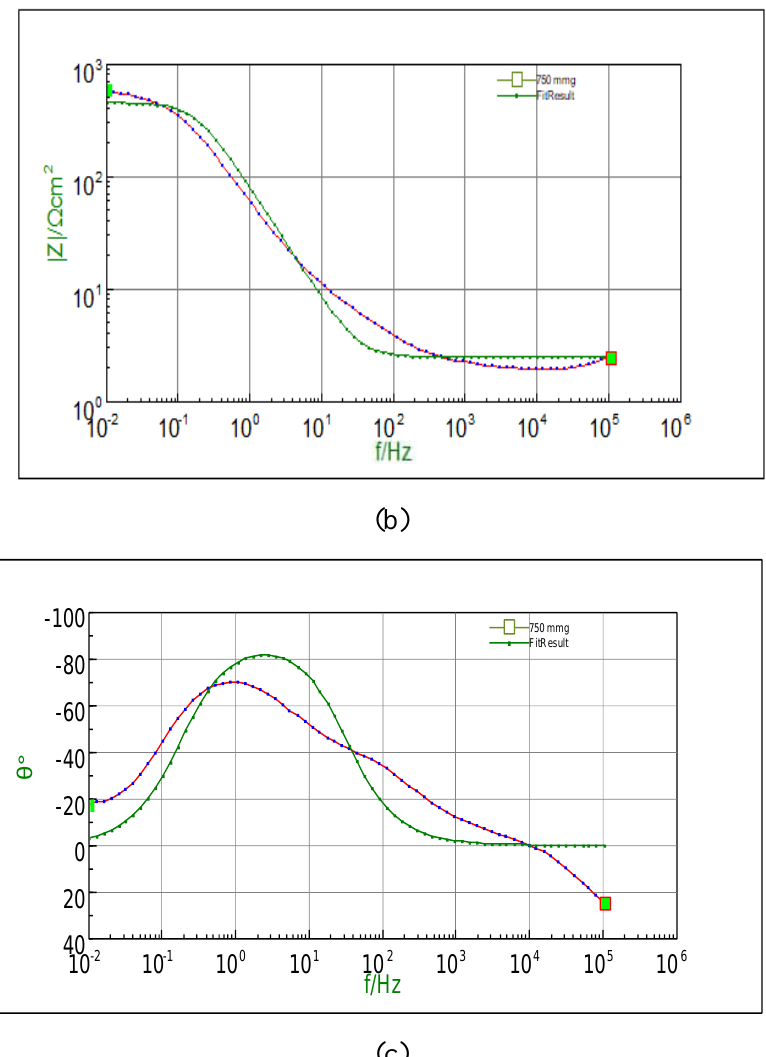
Fig. 14. The EIS test for 750 mg/l concentration of inhibitor at 55◦C with the fitting result. (a) Nyquist plot, (b, c) Bod (log versus |z|), and phase angle (log f versus ∝ 𝟎 )